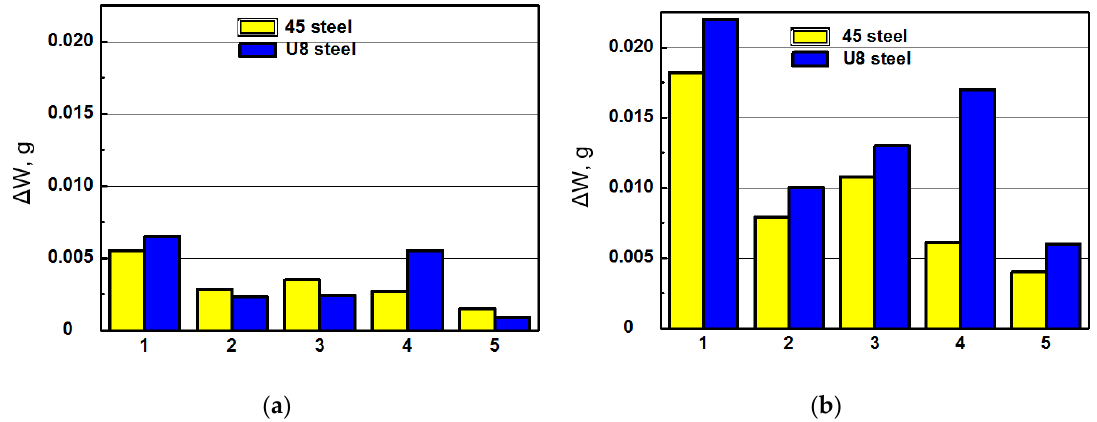
Figure 5. The mass loss of the 45 and U8 steels after their tribocontact with PEO layers synthesized on the AMg-6 ( a ) and D16T ( b ) alloys estimated by the weight losses Δ W of specimens tested at unit load level of 4 MPa within 4 h: in the pure mineral oil of the I-20 type ( 1 ); after their hydrogenation within 1 h at current density 2.0 A/dm 2 with following friction in the mineral oil of the I-20 type with the addition of 0.5 vol. % distilled water ( 2 ); after hydrogenation of specimens followed by their holding in air within 15 min ( 3 ) and 24.0 h ( 4 ) to provide the diffusive or residual hydrogen in the metal, correspondently; in the mineral oil of the I-20 type with the addition of 1.0 vol. % 2.5% aqueous solution of glycerin ( 5 ).